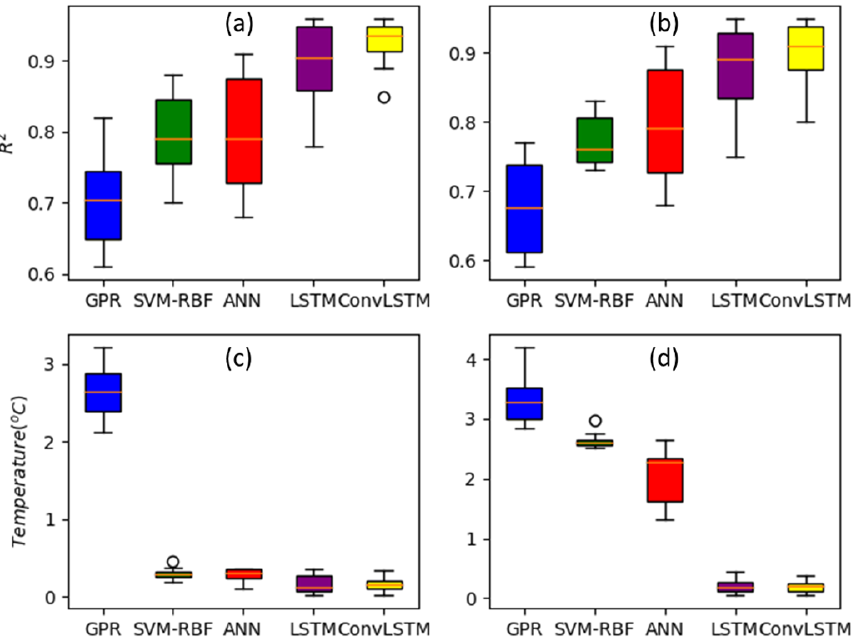
Figure 8. Distribution of SWTSCV performance metric evaluation scores, 10-R 2 , and RMSE scores for each algorithm because the sliding windows were split into 10-time series splits. The subplots column ( a , c ) are R 2 and RMSE for L8, similarly ( b , d ) shows the same for S3.